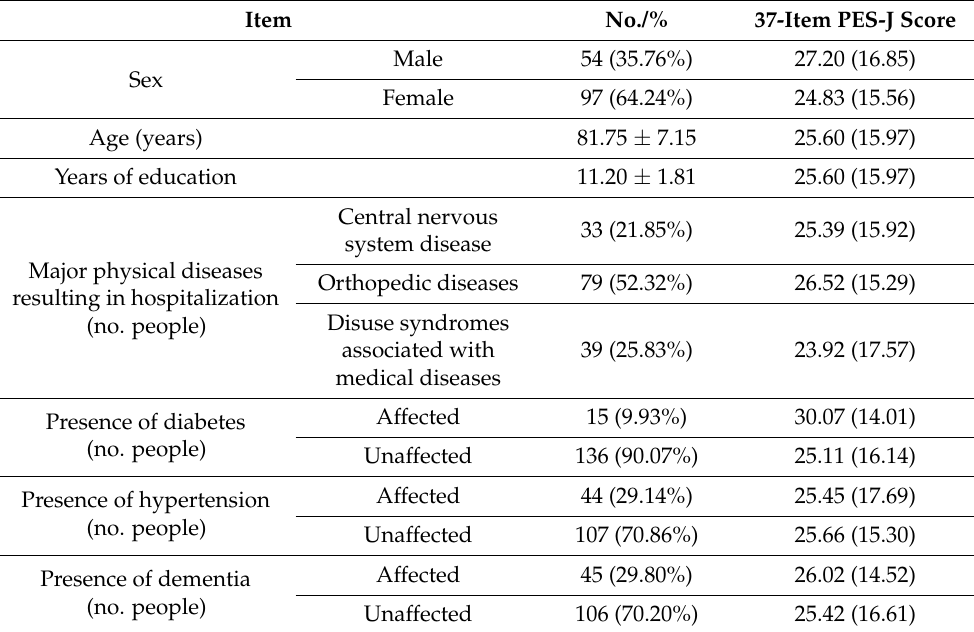
Table 1. Characteristics of participants.